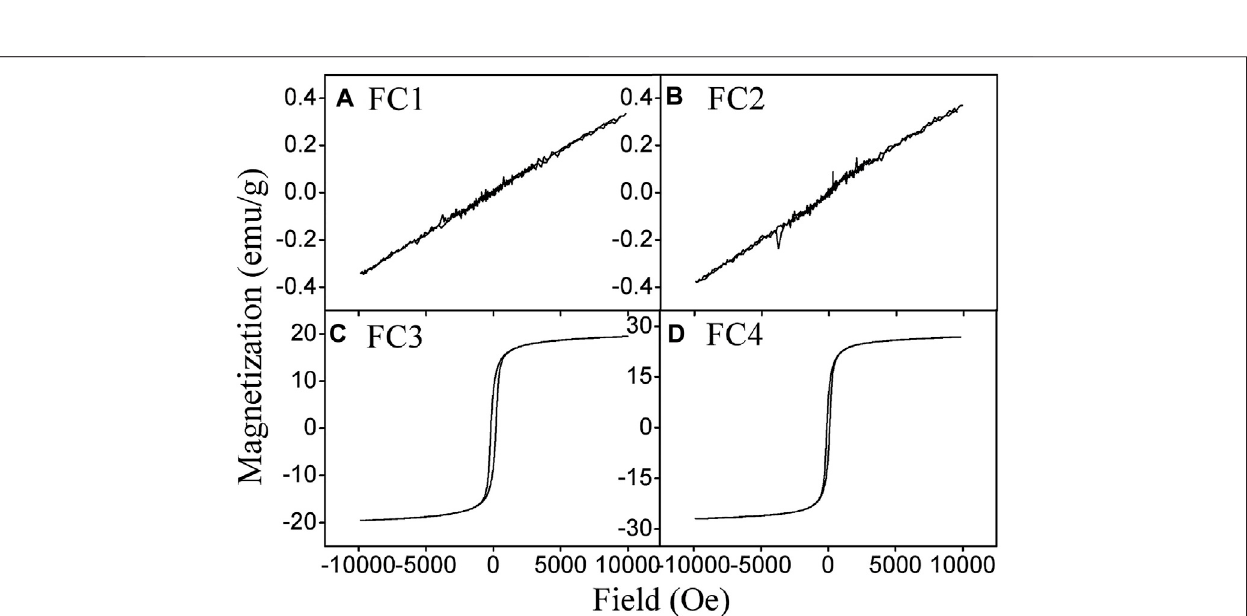
FIGURE 3 | Magnetization loops of the prepared Fe-Cu binary oxides: (A) FC1, (B) FC2, (C) FC3 and (D) FC4.